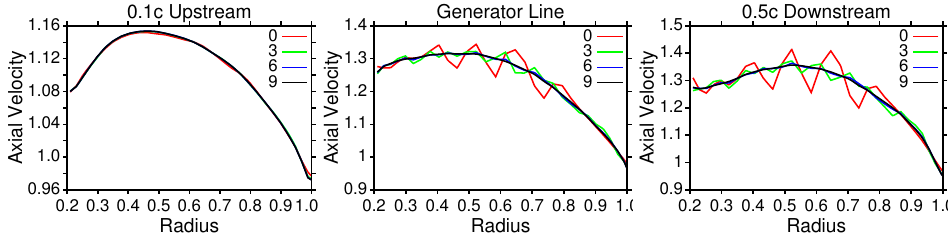
Figure 7. The variation of the axial velocity with split